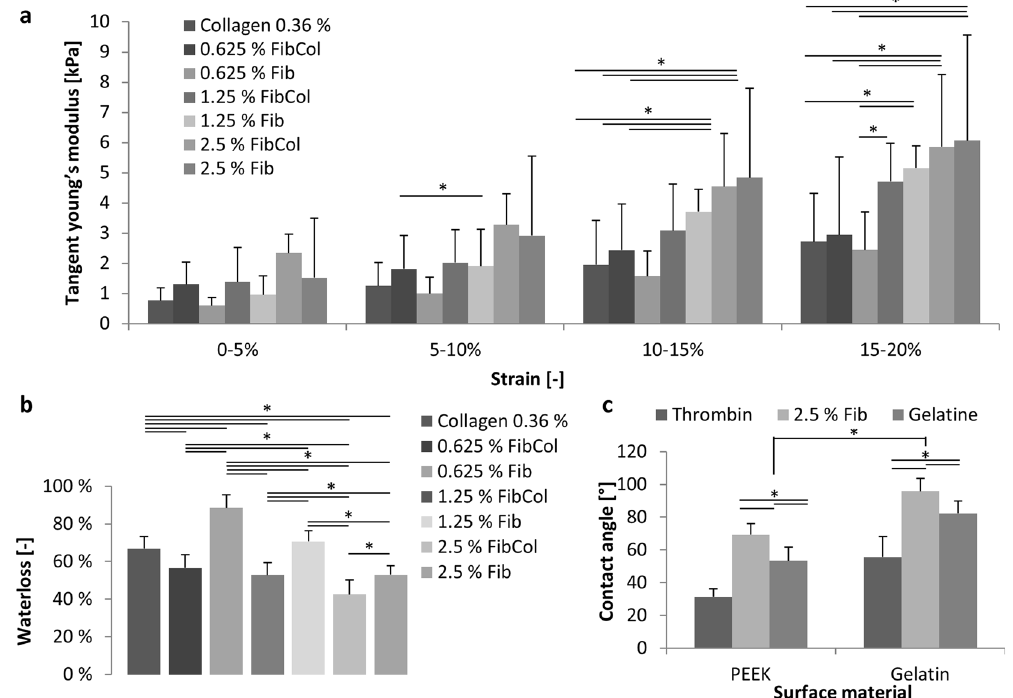
Figure 2. Characteristics of the materials used. ( a ) Tangent Young’s modulus of material combinations used. Measured tangent Young’s modulus between 0 and 20% strain calculated in 5% steps for multiple material combinations (n = 4; * p < 0.05). ( b ) Water loss as a ratio of the original weight after compression. Lower concentrations of fibrin show significantly higher water losses. The addition of collagen reduces the water lost after compression (n = 4). ( c ) Contact angle measurements for thrombin, fibrinogen and gelatine solution on PEEK and gelatine surface materials (n = 6; * p <